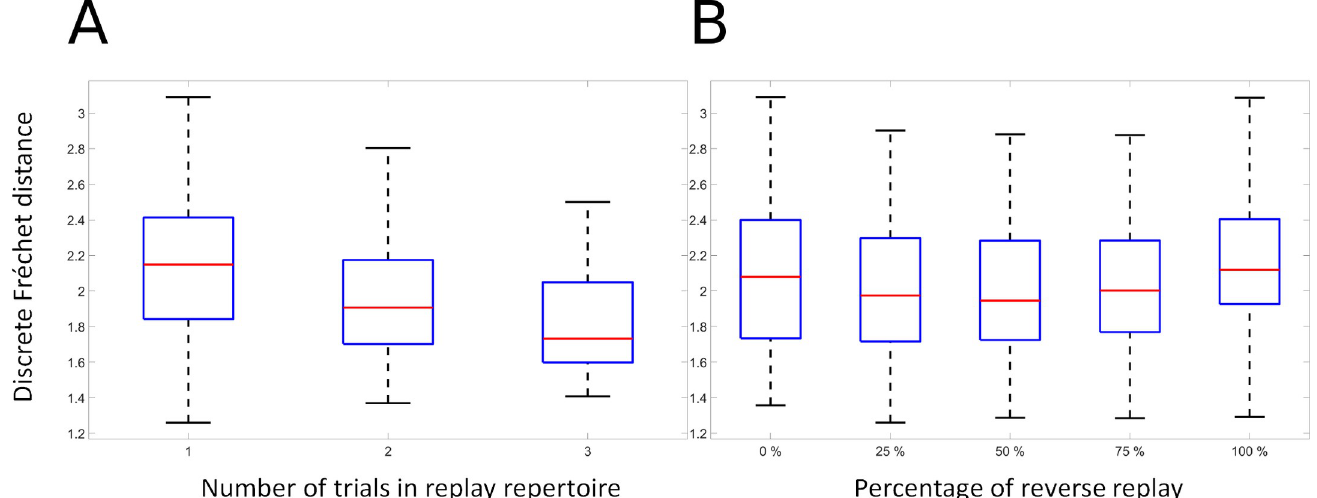
Fig 10. Consolidation and reverse replay applied to behavioral data. Measured variable is Frechet distance between generated and desired sequence. Data from the rat TSP configurations are used for training and testing the model. A. Effects of consolidation: as successive trials are added to the replay repertoire; the trajectory reconstruction error is significantly reduced. B. Effects of reverse replay: as reverse replay is introduced in snippet formation for training the PFC model, reconstruction error is significantly reduced.